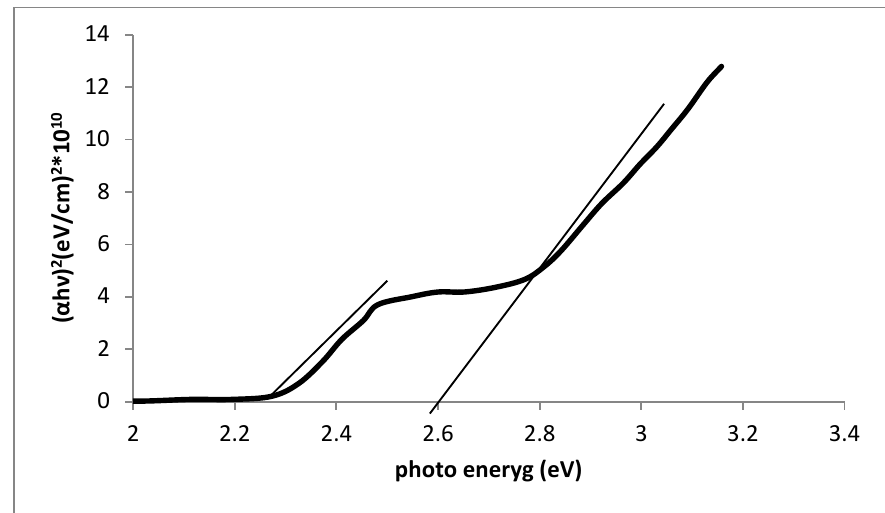
Fig.5: (  h  ) 2 versus Photon energy for CdSe/CdS core-shell nanoparticles.